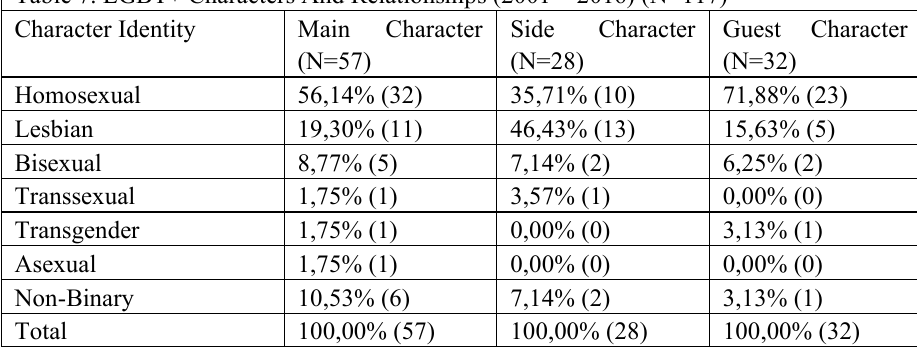
Table 7. LGBT+ Characters And Relationships (2001 – 2016)